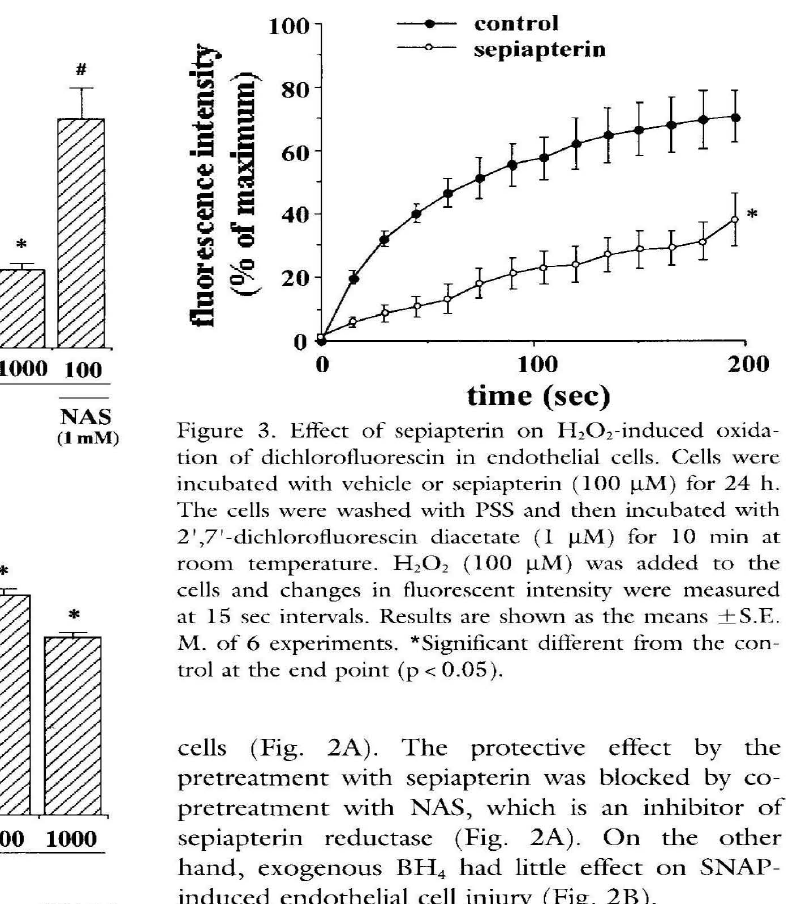
Figure 2 . Effects of sepiapterin and BH. on SNAP-in duced LDH release from endothelial cells. A; Cells were incubated with sepiapterin (1-1 000 ~M) or sepiapterin (100 ~M) plus NAS (1 mM) for 24 h. The cells were washed with PSS and then incubated with SNAP (2 mM) for 10 h at 37°C. B; Cells were incubated with SNAP (2 mM) in the presence of various concentrations of BH. (I I 000 ~M). Typical results from 3 experiments are shown as the means ±S.E.M. of quadruplicate assays. *Sig nificant change in comparison to control group (p < 0 .05). #Significant change in comparison to sepiapterin (100 ~M) alone group (p<0.05).